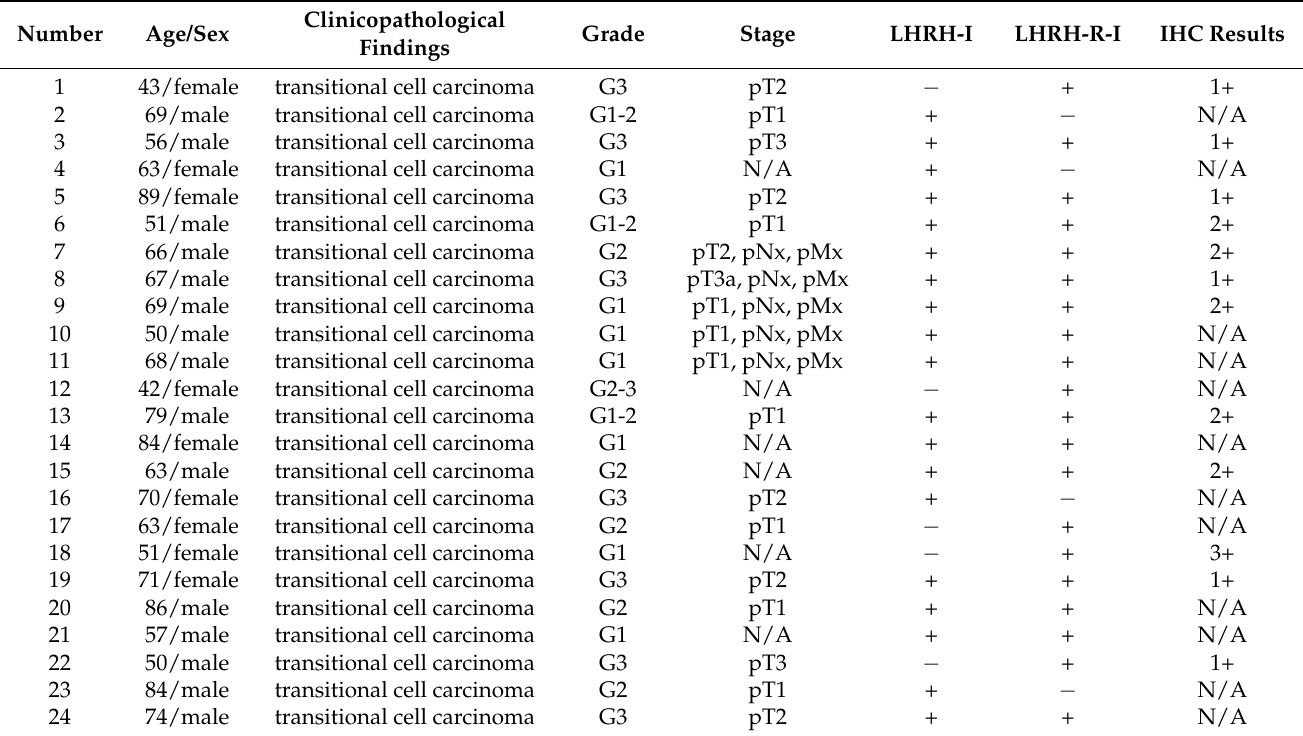
Table 2. Clinicopathological findings, mRNA expression pattern of LHRH-I and LHRH-R-I; LHRH receptor protein expression in human bladder cancer